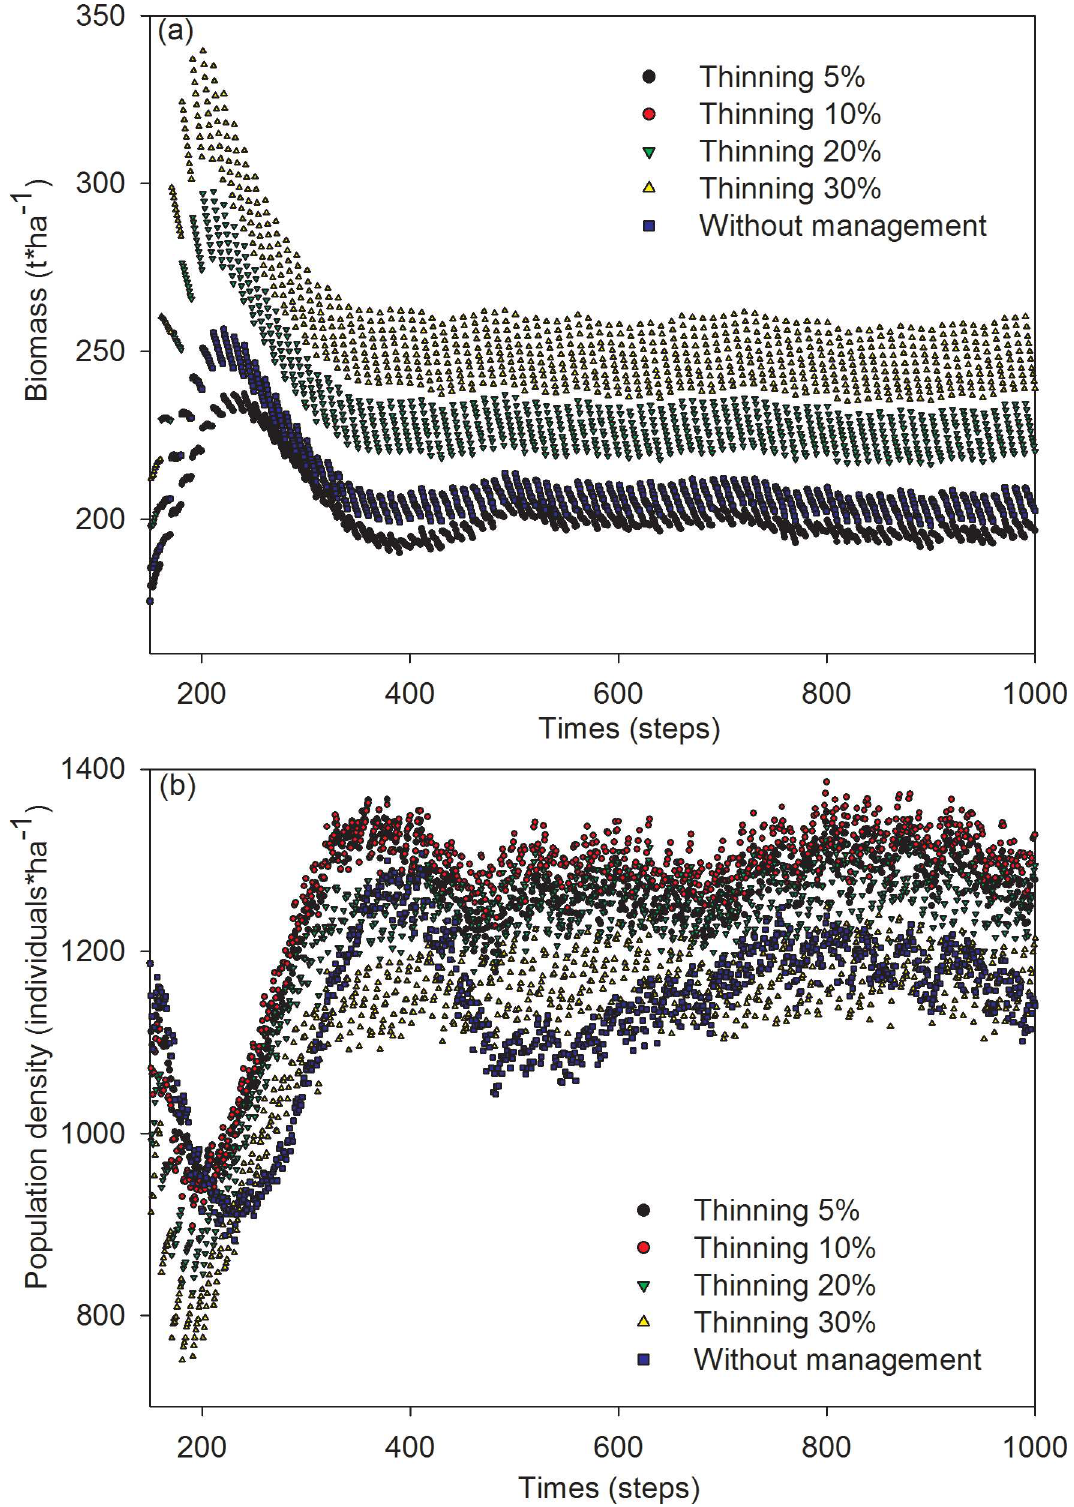
Fig 3. Simulation results of the effects of thinningon biomass(a) and population density (b) of over mature trees in Mongolian pine